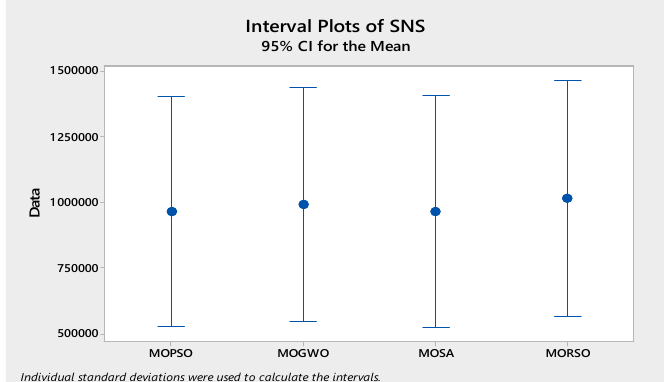
Figure 22. Interval plots of SNS.